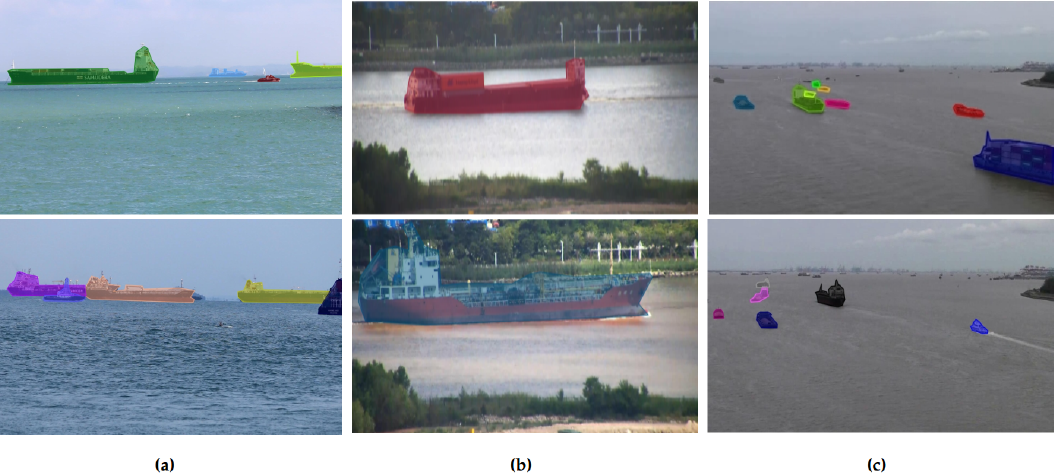
Figure 6. Annotated masks on existing datasets for the study of the generalisation of our models. ( a ) Annotated examples of the SMD [12]. ( b ) Annotated examples of Seaships7000 [13]. ( c ) Annotated examples of the dataset by Chen et al. [14].